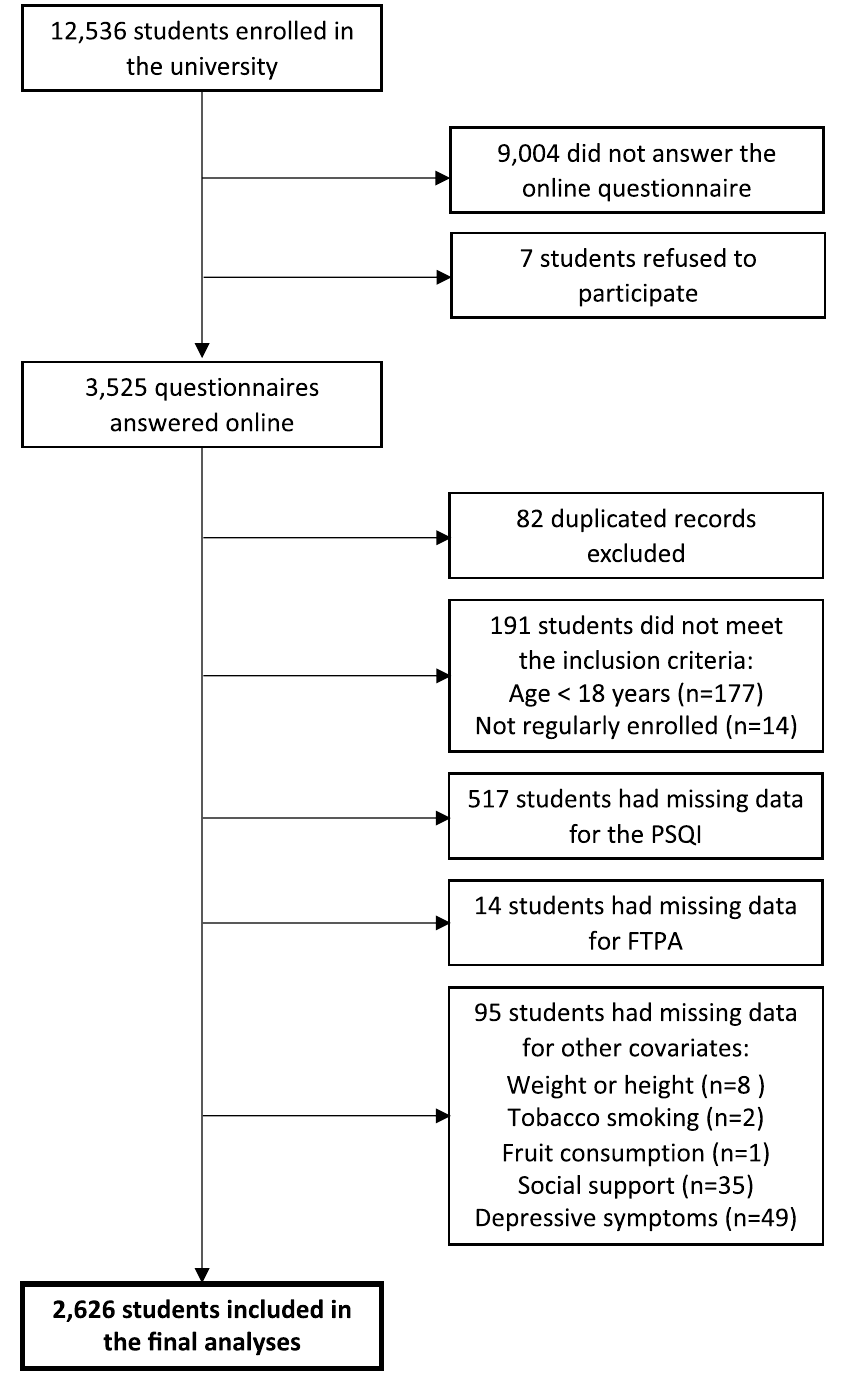
Figure 3. Flow diagram of the study